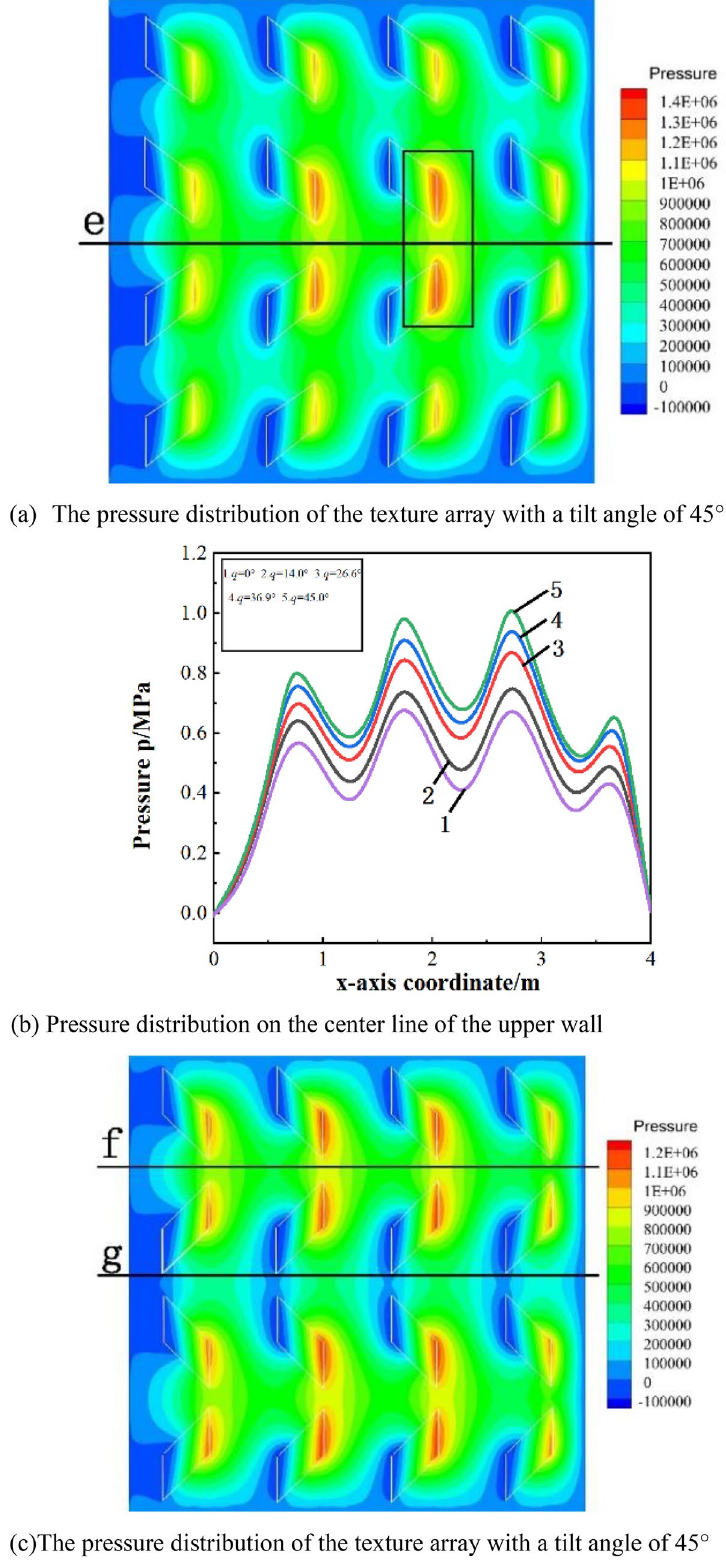
Figure 5. Pressure distribution with different tilt